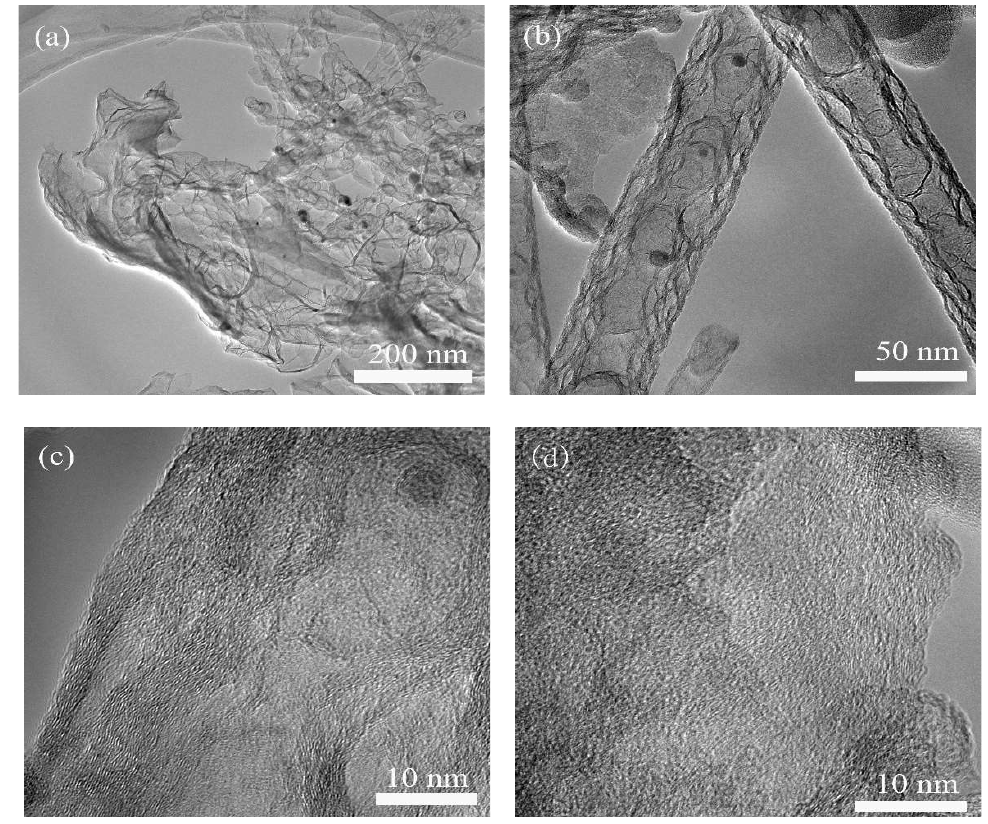
Figure 2. ( a , b ) TEM images of the Fe-N x -GNT-2-1000 composite catalyst. ( c , d ) HRTEM images of the as-obtained Fe encapsulated in graphene layer.